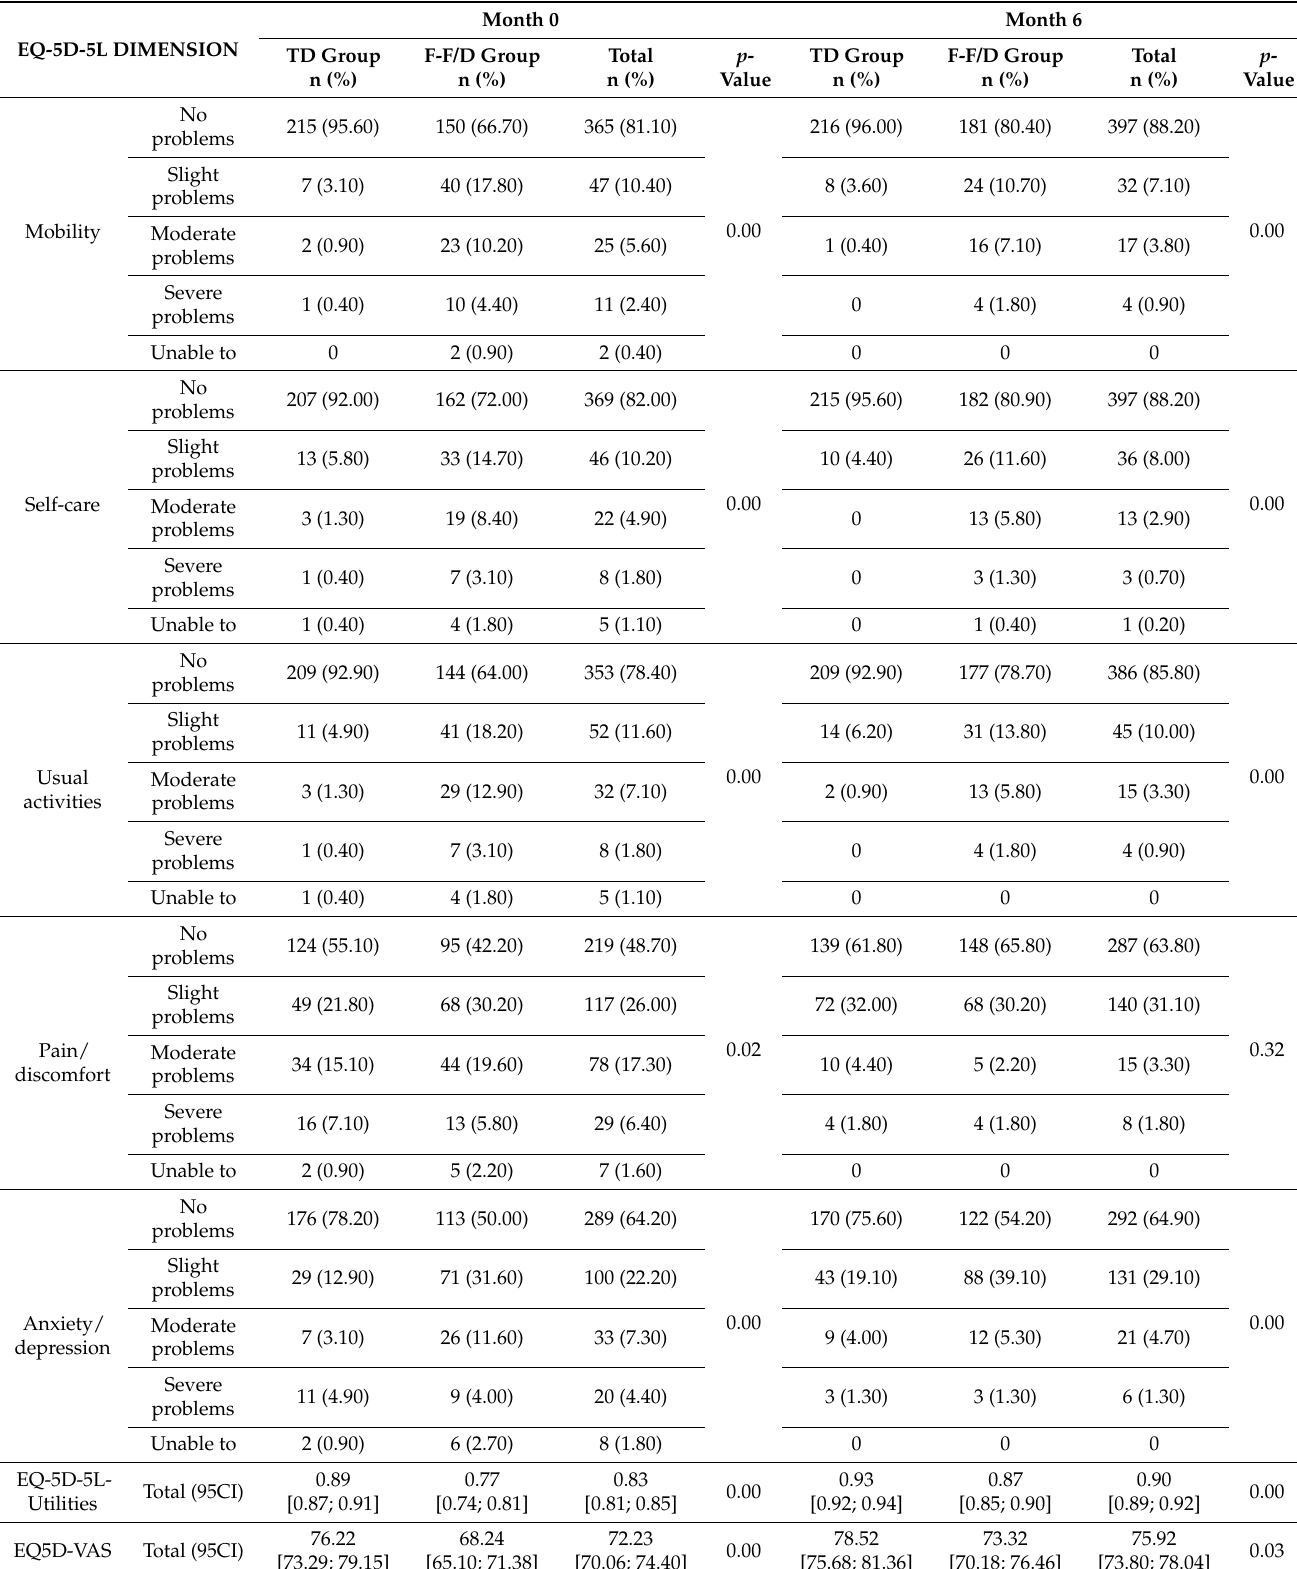
Table 2. Changes in HRQoL between baseline and 6 months after the first visit, across EQ-5D-5L-